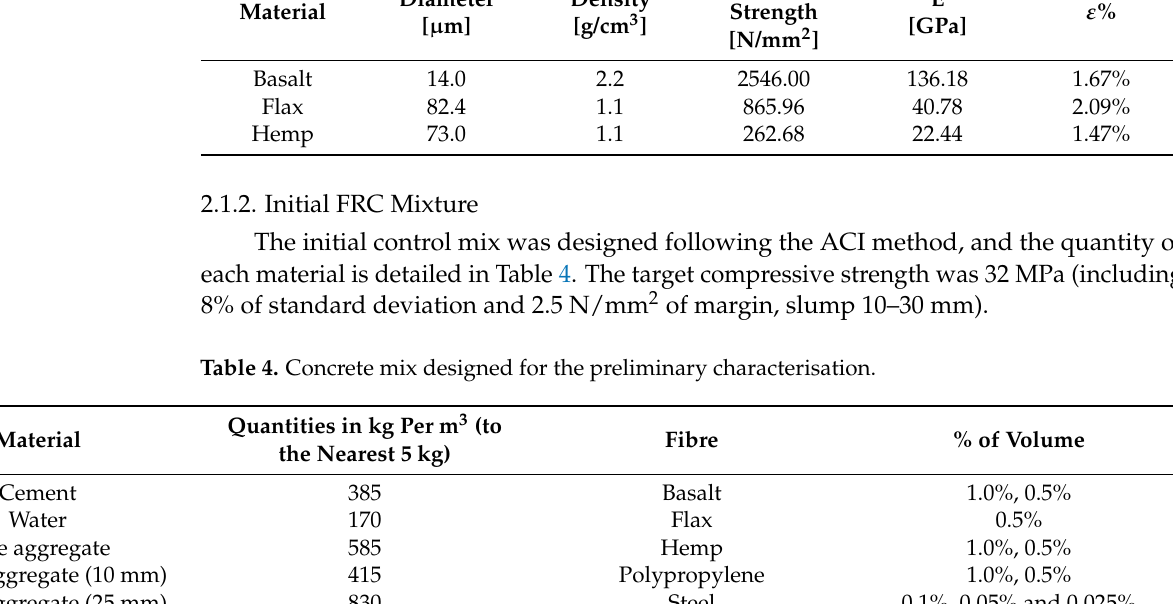
Table 4. Concrete mix designed for the preliminary characterisation.